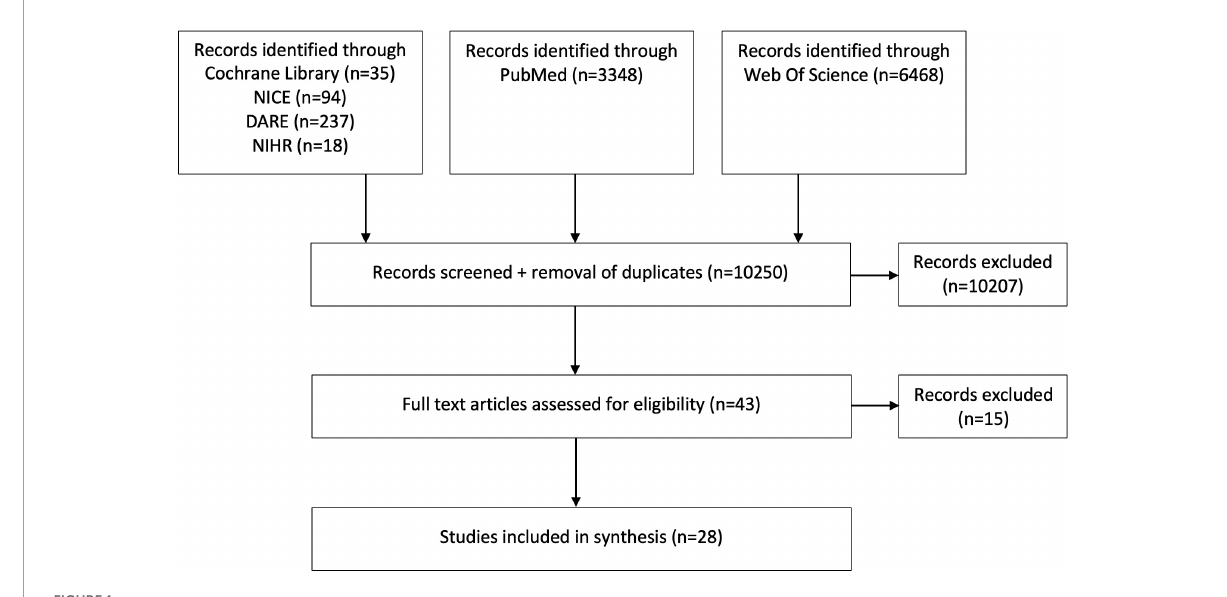
FIGURE1 Study selection flow